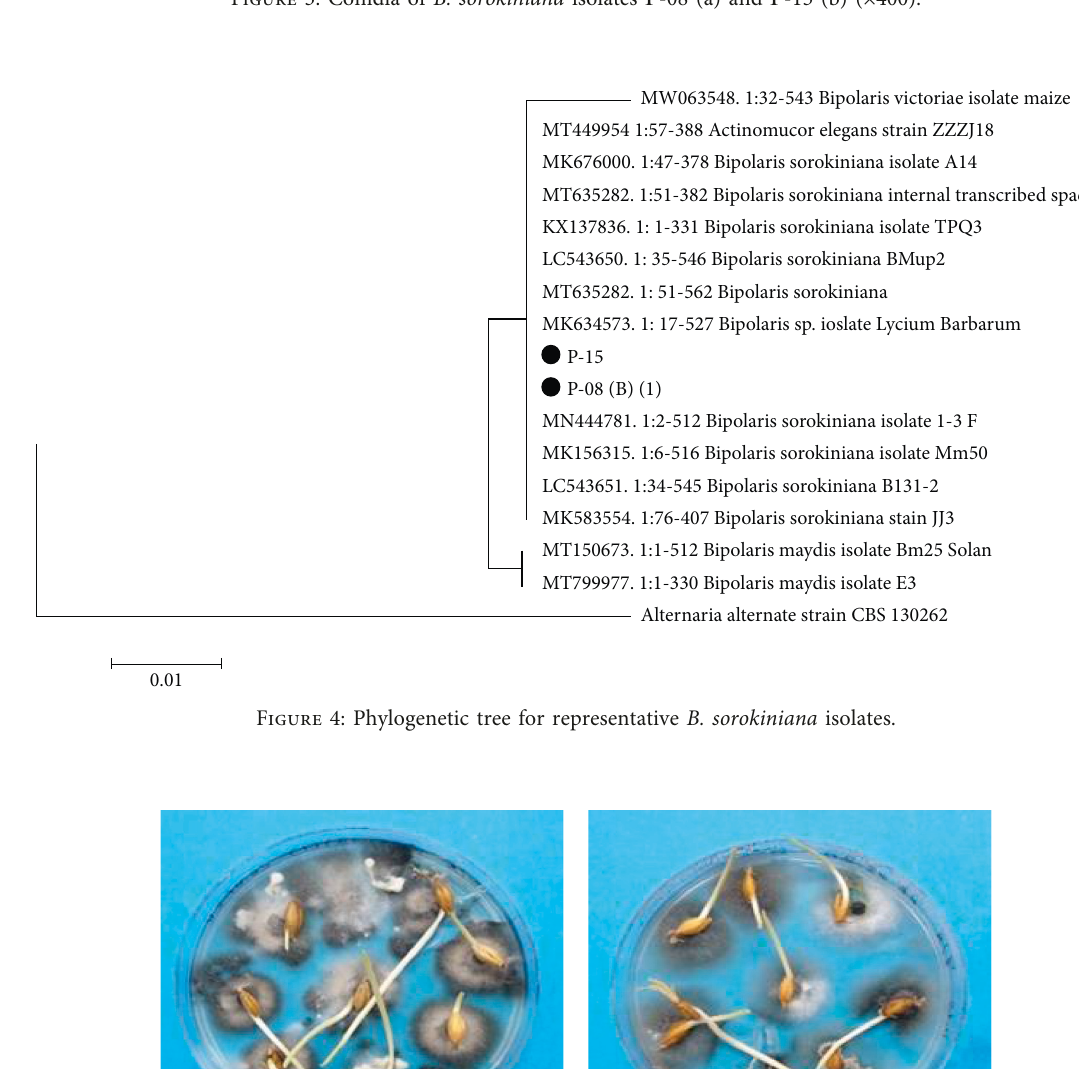
Figure 3: Conidia of B. sorokiniana isolates R -08 (a) and R -15 (b) ( × 400).